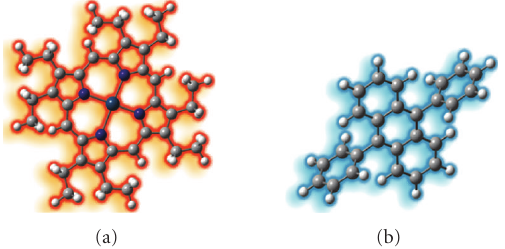
Figure 1: Molecular structures of (a) Pt(II)octaethylporphyrin and (b) 9,10